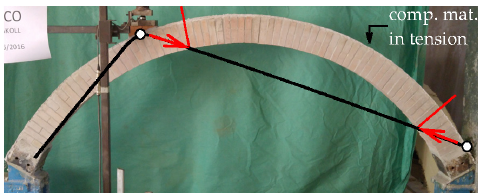
Figure 8. Schematic thrust line of the extrados ‐ strengthened arches.